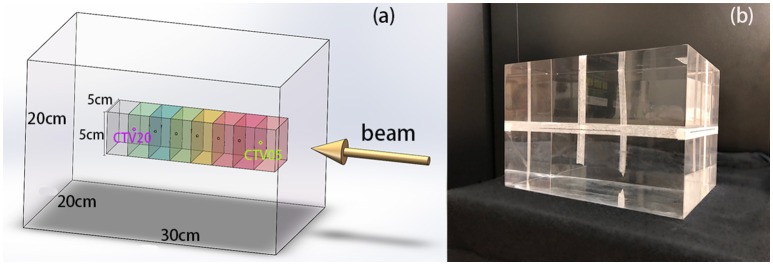
(A) 3D model of the phantom, CTVs, and beam direction. The center points of the CTVs are located along the beam line, with different distances to the beam entrance surface. (B) PMMA phantom used in the experiments.